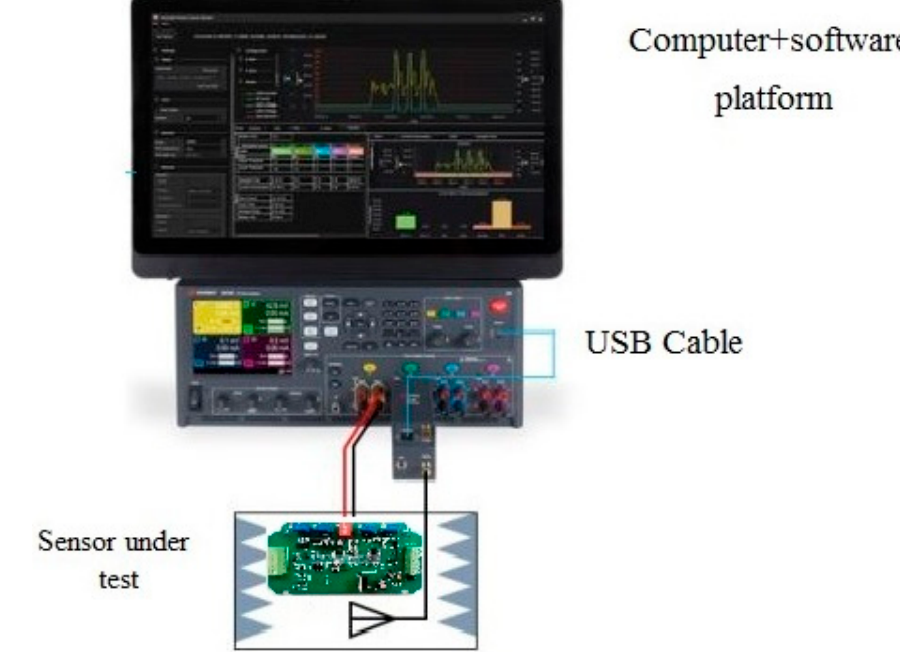
Figure 11. The picture of the sensor test equipment. Sensors 2019 , 19 , x FOR PEER REVIEW